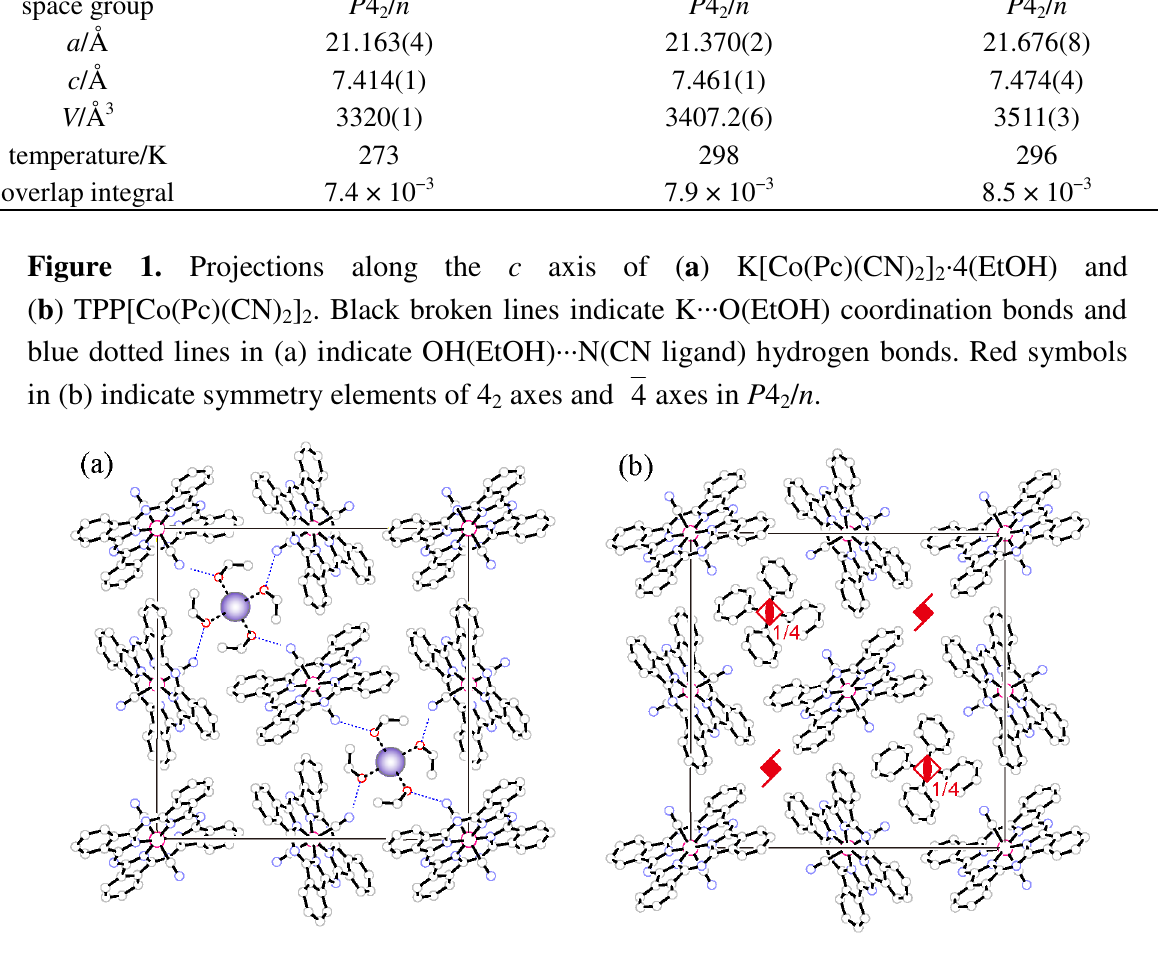
.4(EtOH), and TPP[Co(Pc)(CN) ] 2 2 Na[Co(Pc)(CN)